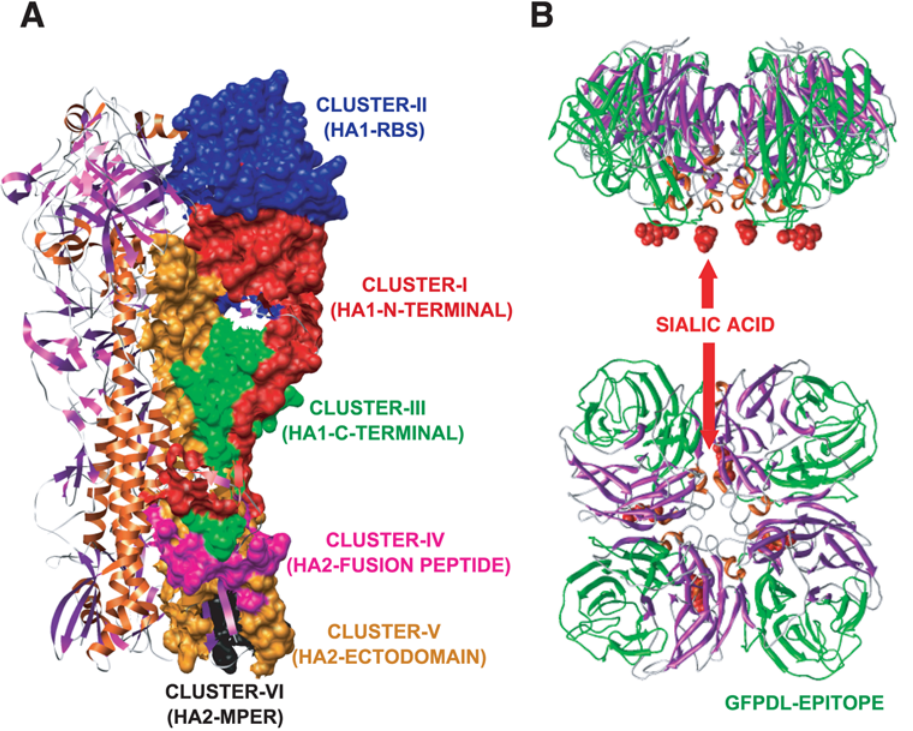
Figure 4. Main antigenic clusters in the structures of HA and NA recognized by antibodies from H5N1 virus infected individuals. (A) Antigenic clusters in HA, as identified in Figure 3B, are shown as surface exposed colored patches on one HA monomer within the HA trimer structure (PDB identifier 2IBX). The antigenic clusters (I–III) in HA1 cover the Antigenic Sites a, b, c, d, and e that have been described in the H3 HA1 based on mouse MAbs [15,22]. (B) The immunodominant conformational epitope in the NA (NA-3676-3854, peptide 15 in Figure 3B) is shown in green on the tetrameric NA structure (PDB Identifier 2HTY) with the predicted site of bound sialic acid shown in red. Side view and bird-eye views are shown.